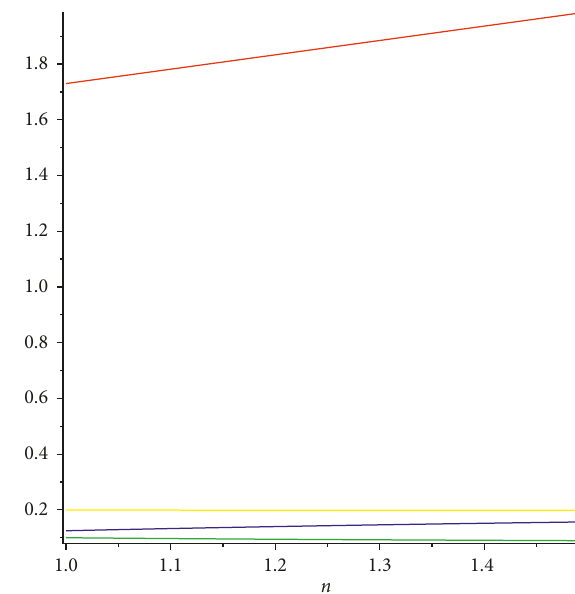
P n n , PETIM, DPZ n , and PETAA.